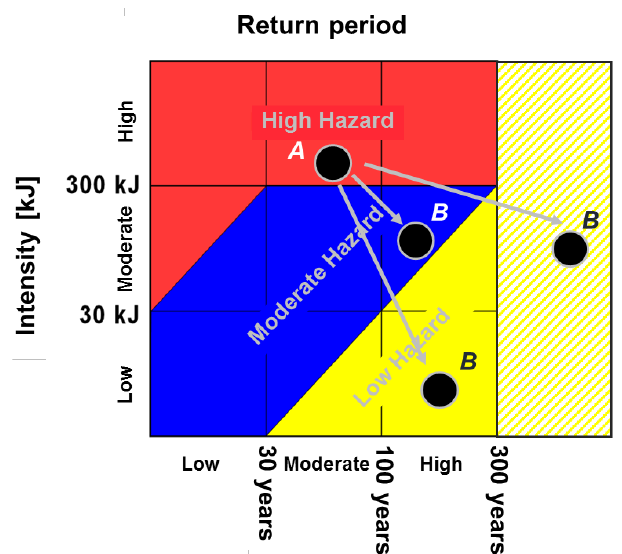
Figure 10. Example of possible hazard reclassification at a given location of the slope, starting from a natural scenario characterised by high